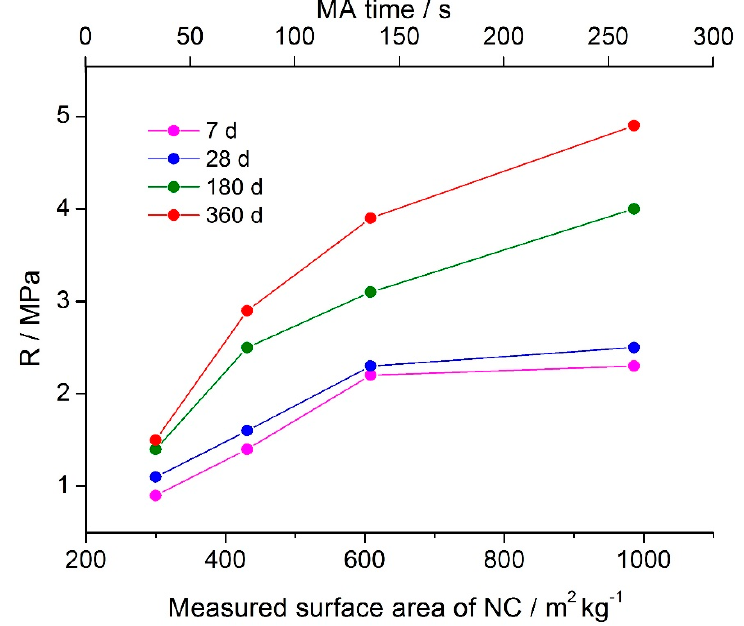
Figure 4. The compressive strength (R) of the geopolymer binder based on the NC at 7, 28, 180, and 360 d of age as a function of the measured surface area of the NC and time of MA in air. Activator solution: liquid glass containing 3 wt. % Na 2 O (relative to weight of the NC) with silica modulus of 1.50.